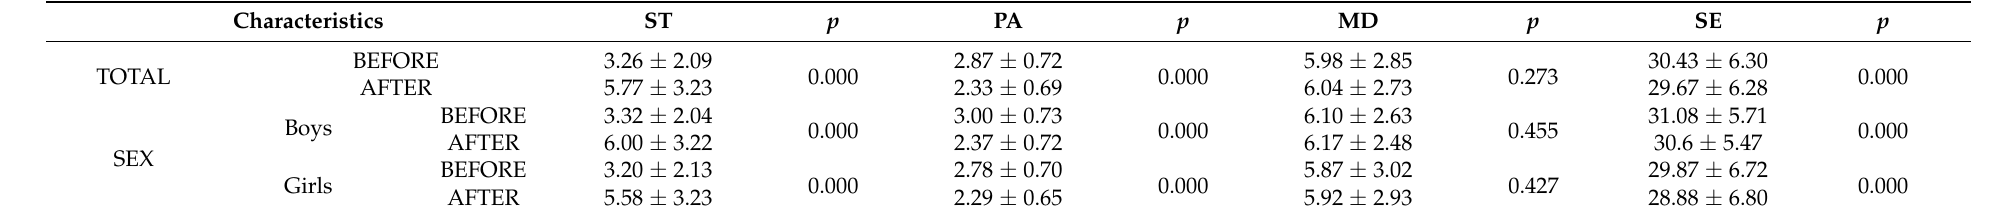
Table 2. Differences in sample characteristics between the period of total confinement and pre-confinement, according to